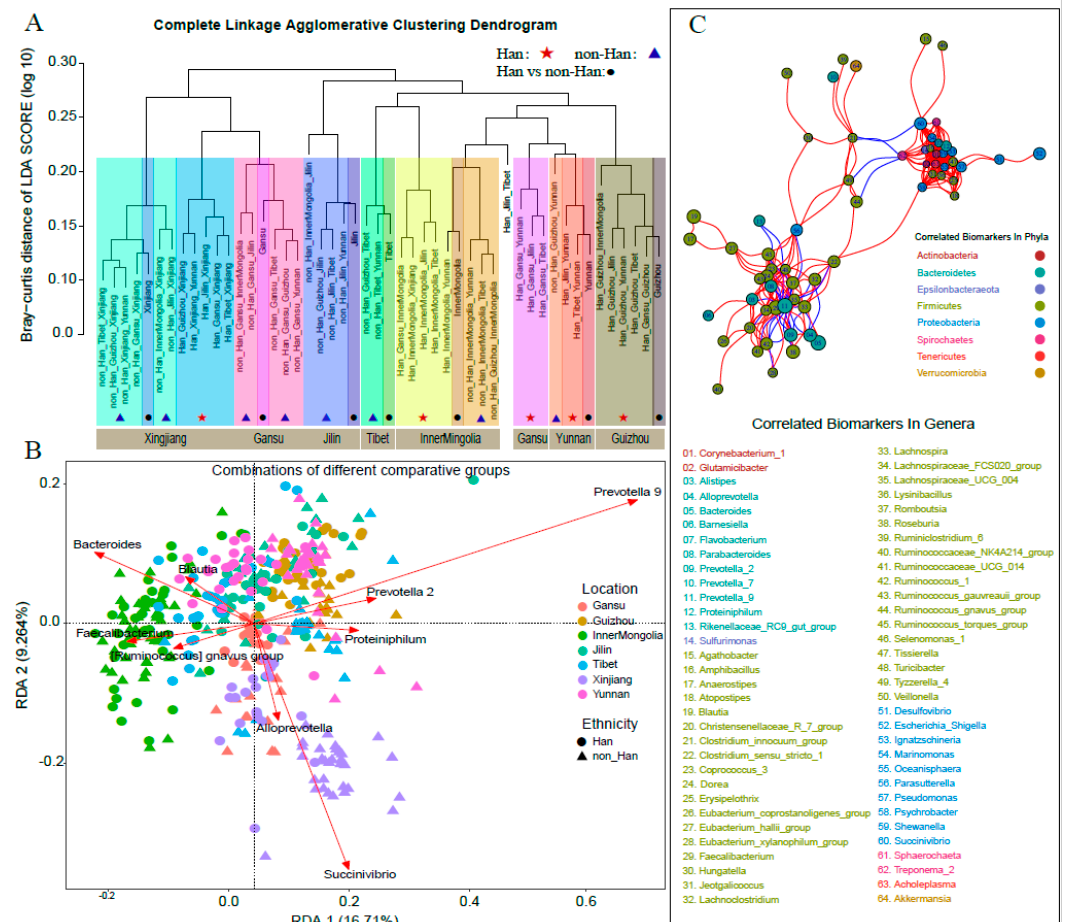
Figure 4. ( A ) Complete linkage agglomerative clustering dendrogram of the Bray–Curtis distance of the LDA score (log 10) between combinations of different comparative groups. The X -axis in brown marks the major geographic location effects. Different geographic or ethnic groups are represented in the other shading colors. ★ , ▲ and ● represented corresponding to the comparison results of di ff erent categories. ( B ) RDA biplot (RDA on a covariance matrix, scaling 2) showing the two first axes of a canonical ordination of 394 samples. Circles and triangles represent different ethnicities [Han and other minorities (non_Han)] with 7 colors to identify geographic location; 655 genera (just showed Top 9 significant genera by using red arrows). ( C ) Co-occurrence network deduced from all genera (Table S6) enriched in 64 bacterial biomarkers which were correlated each other. Sizes of the nodes represent the logarithm of the total number of each genus sequence. Red edges, Spearman’s rank correlation coefficient > 0.5, adjusted p < 0.05; blue edges, Spearman’s rank correlation coefficient < − 0.5, adjusted p < 0.05. Different colors of nodes represent the corresponding phyla. Each node with a number annotated to the genera name were given the corresponding annotation.